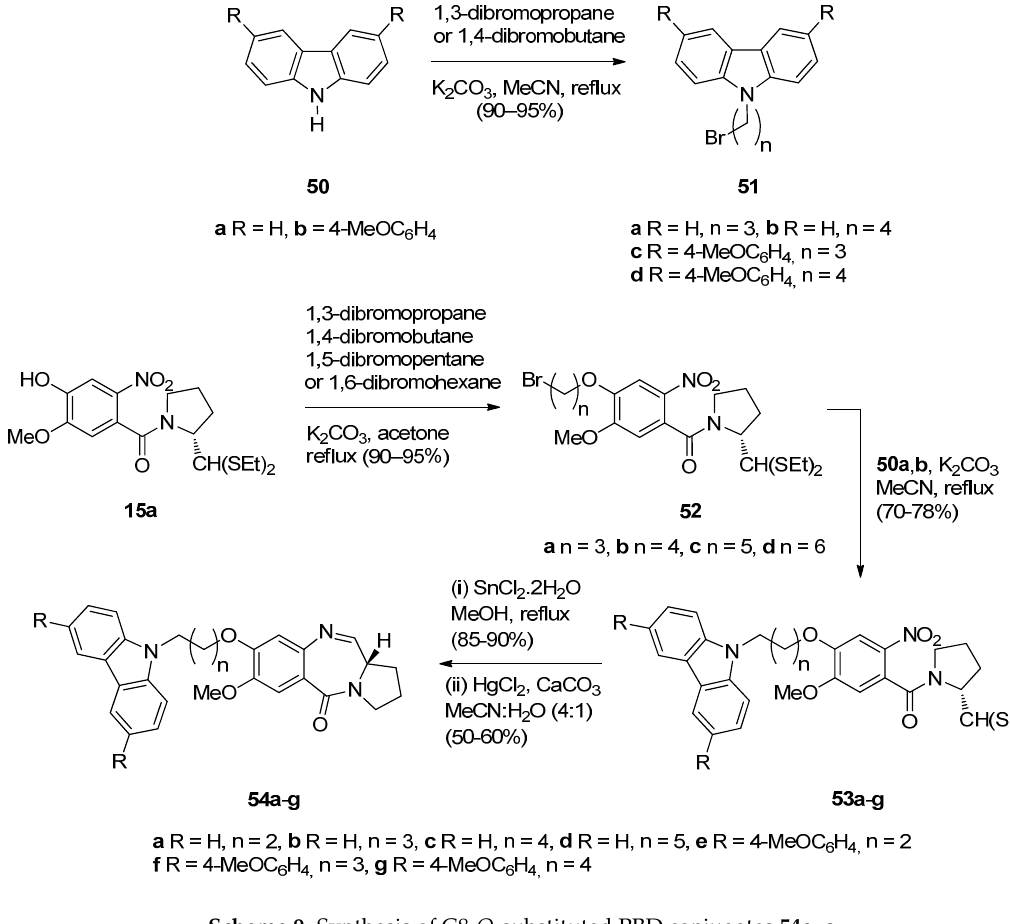
Scheme 9. Synthesis of C8- O -substituted PBD conjugates 54a – g .